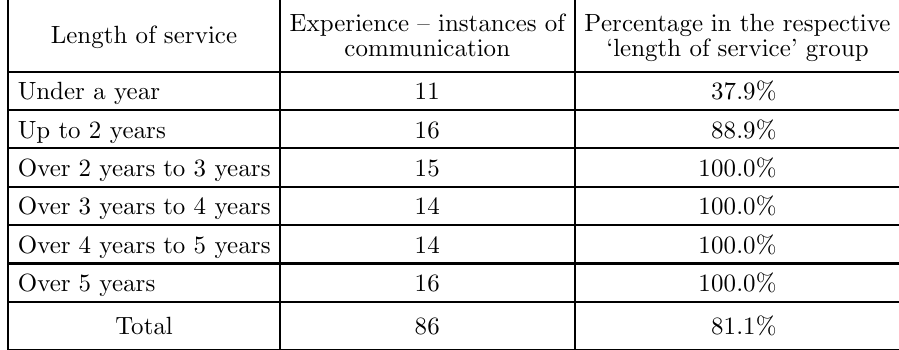
Table 2. Length of service in relation to the experience of communication with an elderly person in suicidal crisis Experience – instances of Percentage in the respective Length of